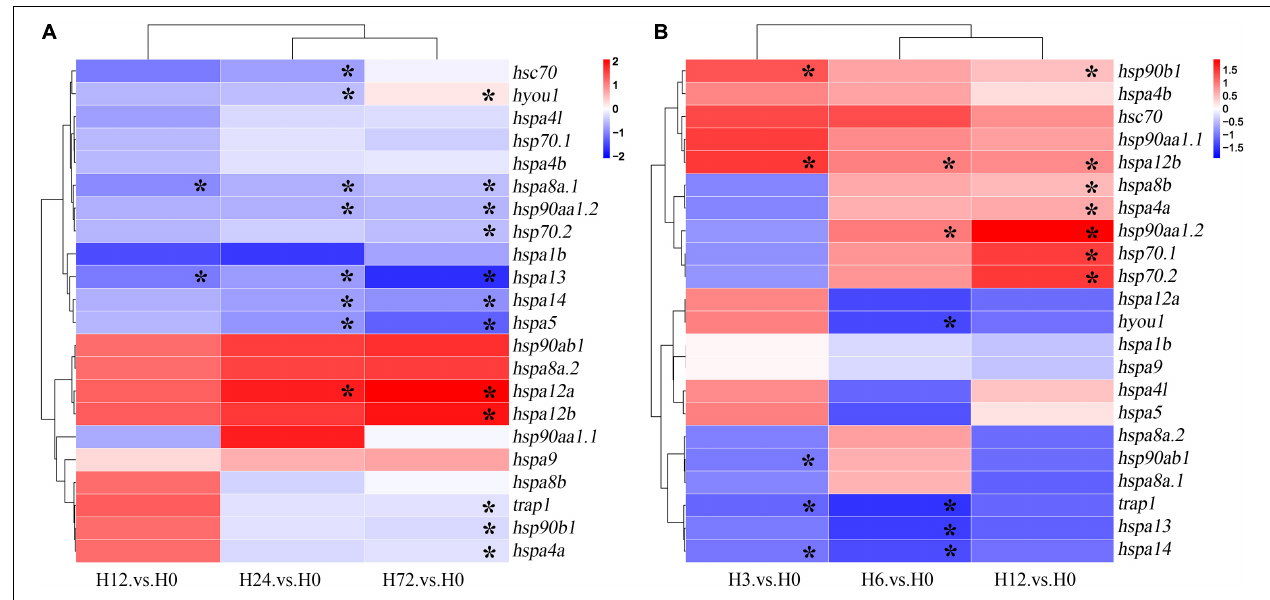
FIGURE 7 | Expression profiles of HSP90 and HSP70 genes in gills of spotted seabass in response to (A) alkalinity and (B) hypoxia stresses. The abundance of mRNA was determined by analyzing the RNA-Seq data. A color scale in the heatmaps represented the fold change values. Asterisk (*) indicated the significant differences ( P < 0.05). HSP, heat shock